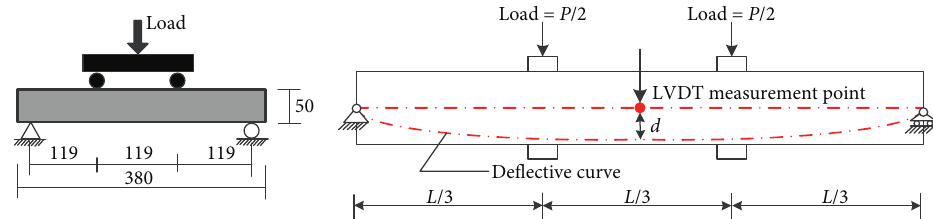
Figure 9: Loading schematic diagram of the four-point bending fatigue test (unit: mm).